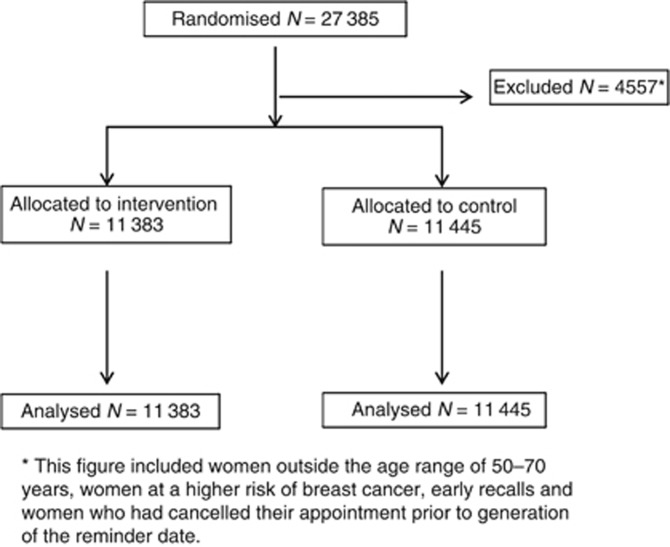
Study procedure (adapted from the CONSORT Transparent Reporting of Trials).